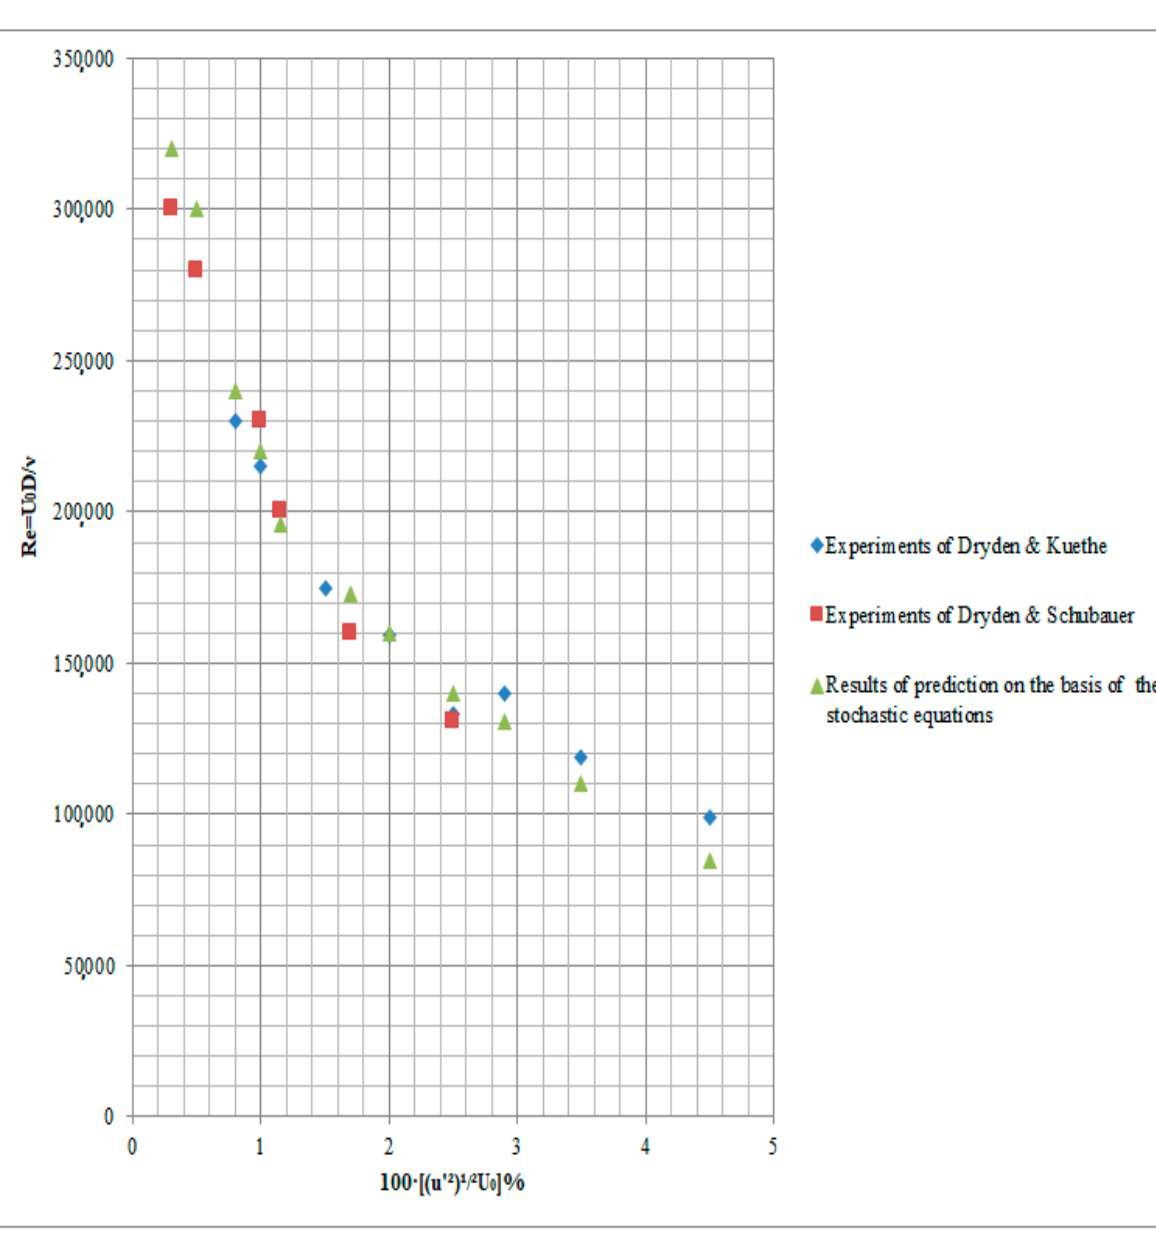
Figure 1. Comparison of calculation with experimental data for the critical Reynolds number on the degree of turbulence during the flow around the sphere [37,68,69].